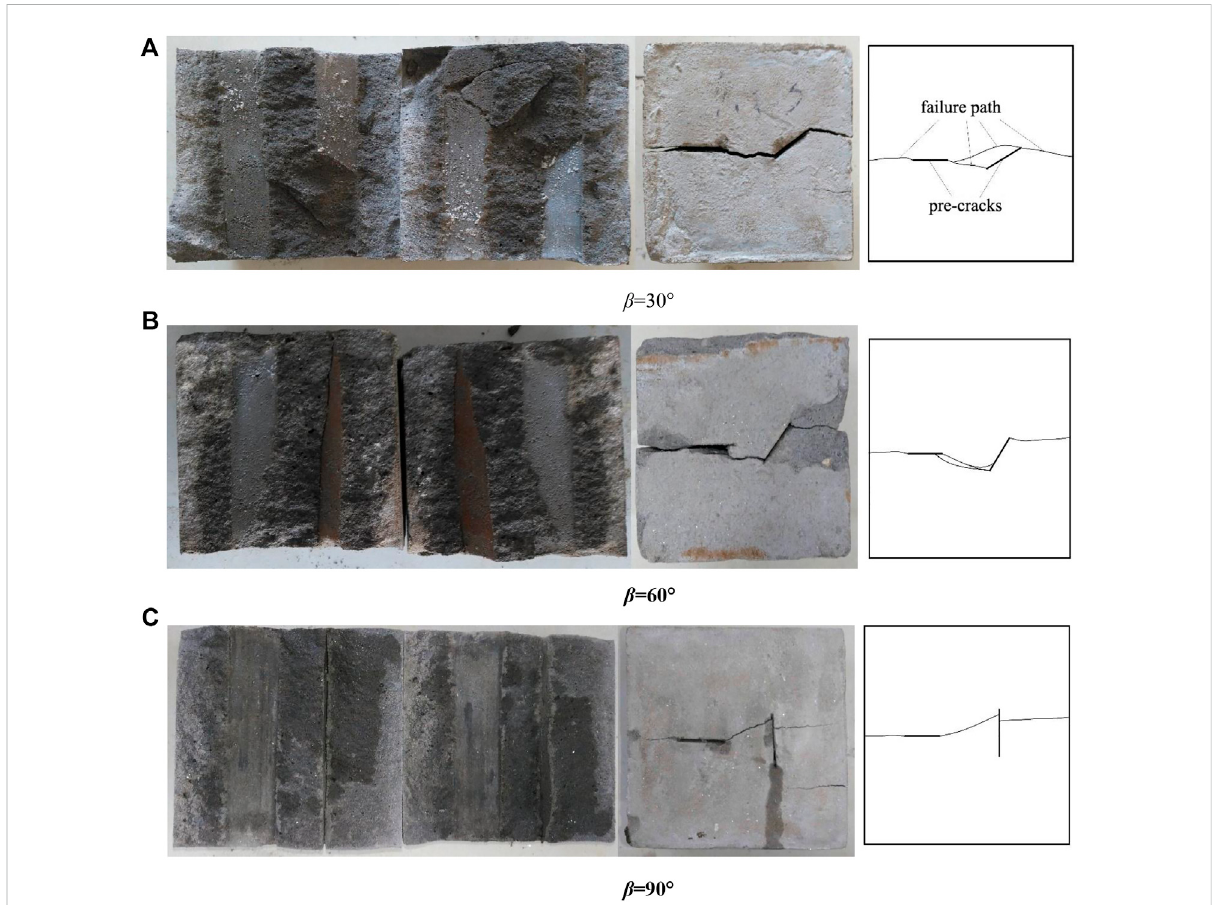
FIGURE 5 Shear failure surface and form of specimens under normal stress of 1 MPa ( α = 0 ° ). (A) β = 30 ° , (B) β = 60 ° , (C) β = 90 °